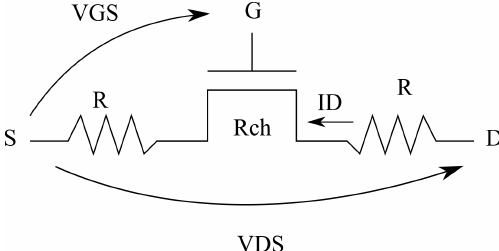
Figure 4. Junctionless nanowire resistance model